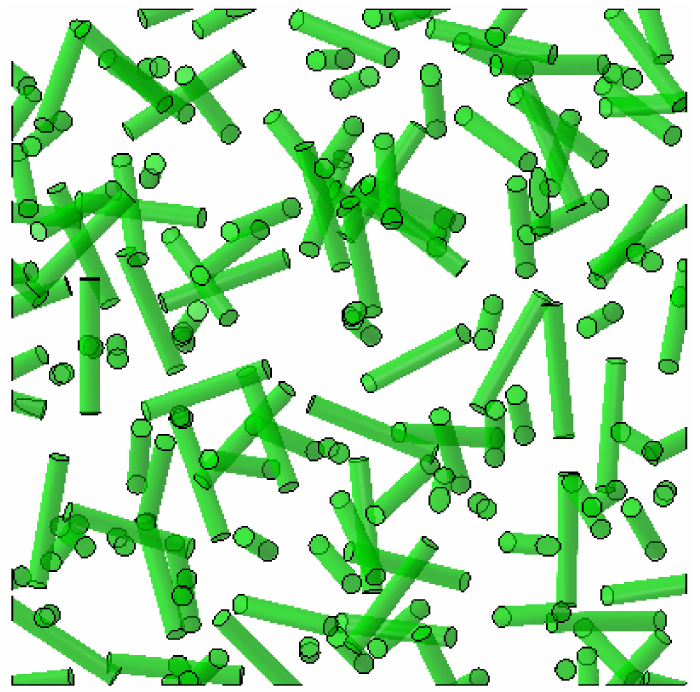
Figure 5. Randomly distributed